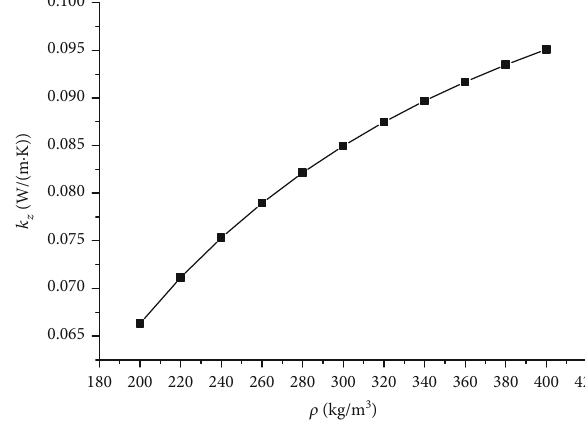
Figure 7: Variation of equivalent thermal conductivity with microsphere density.